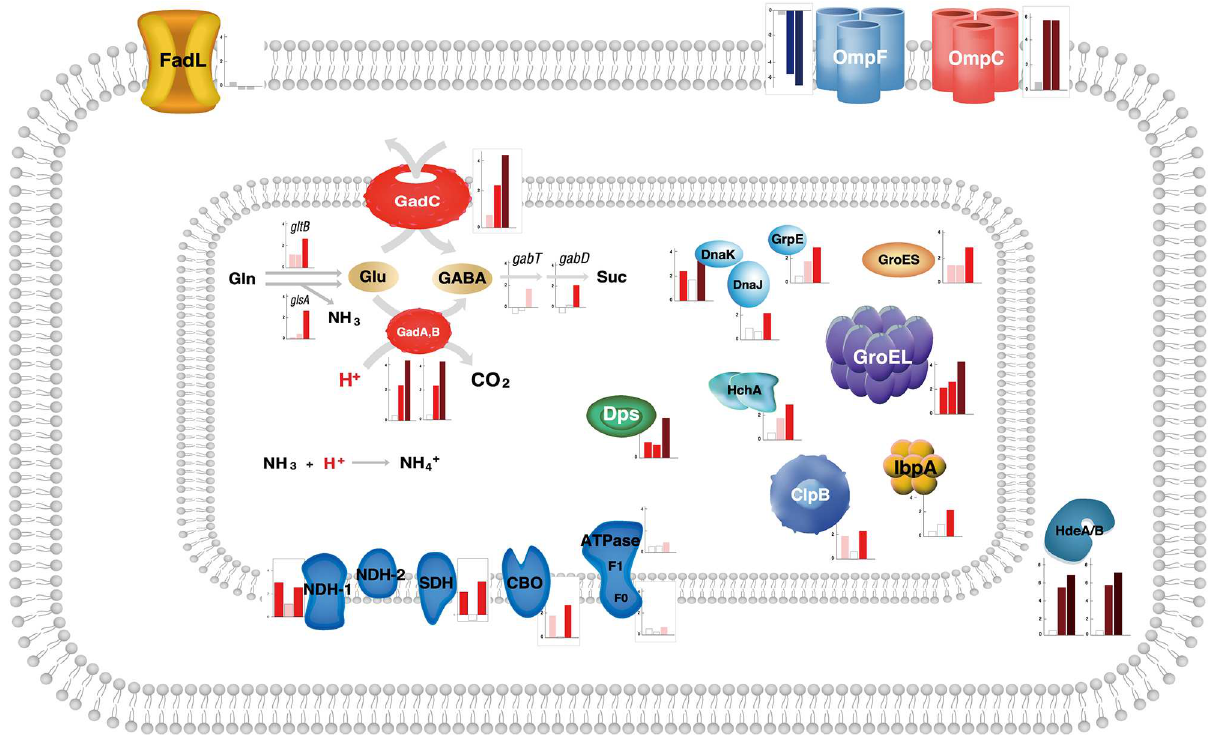
Fig 3. Schematic diagram to show the ratios of expression levels of the genes. The gene products are involvedin the acid resistance systems of E . coli [41] (S3 Table). See Fig 2 for description of the